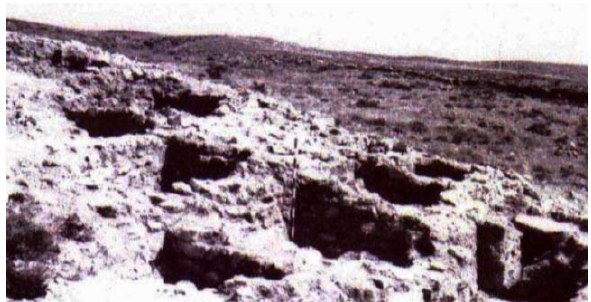
Figure 2. Network of structures made of stone, documented in the archaeological campaign in 1979, actually destroyed